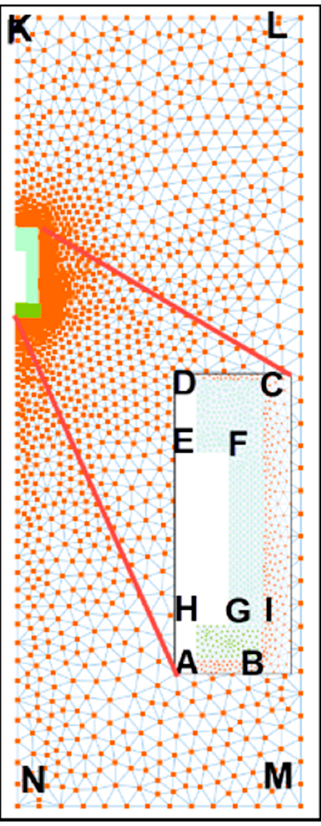
Figure 1. Schematic diagram of the numerical simulation zone for the HYDRUS-2D model.